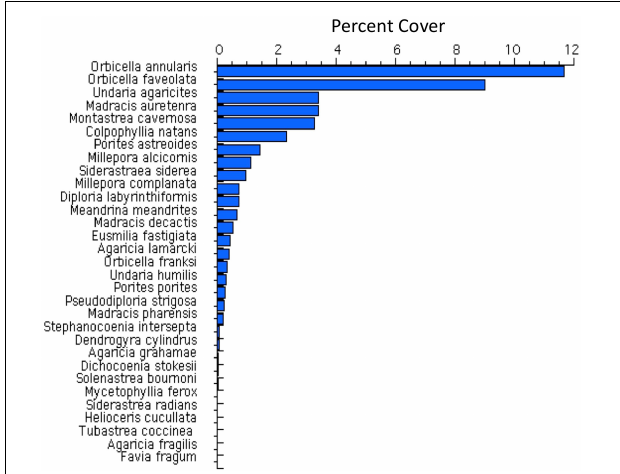
FIGURE 5 | Average percent cover of coral species from all 307 transects quantified from 2004 (when we began documenting individual species) to 2017.